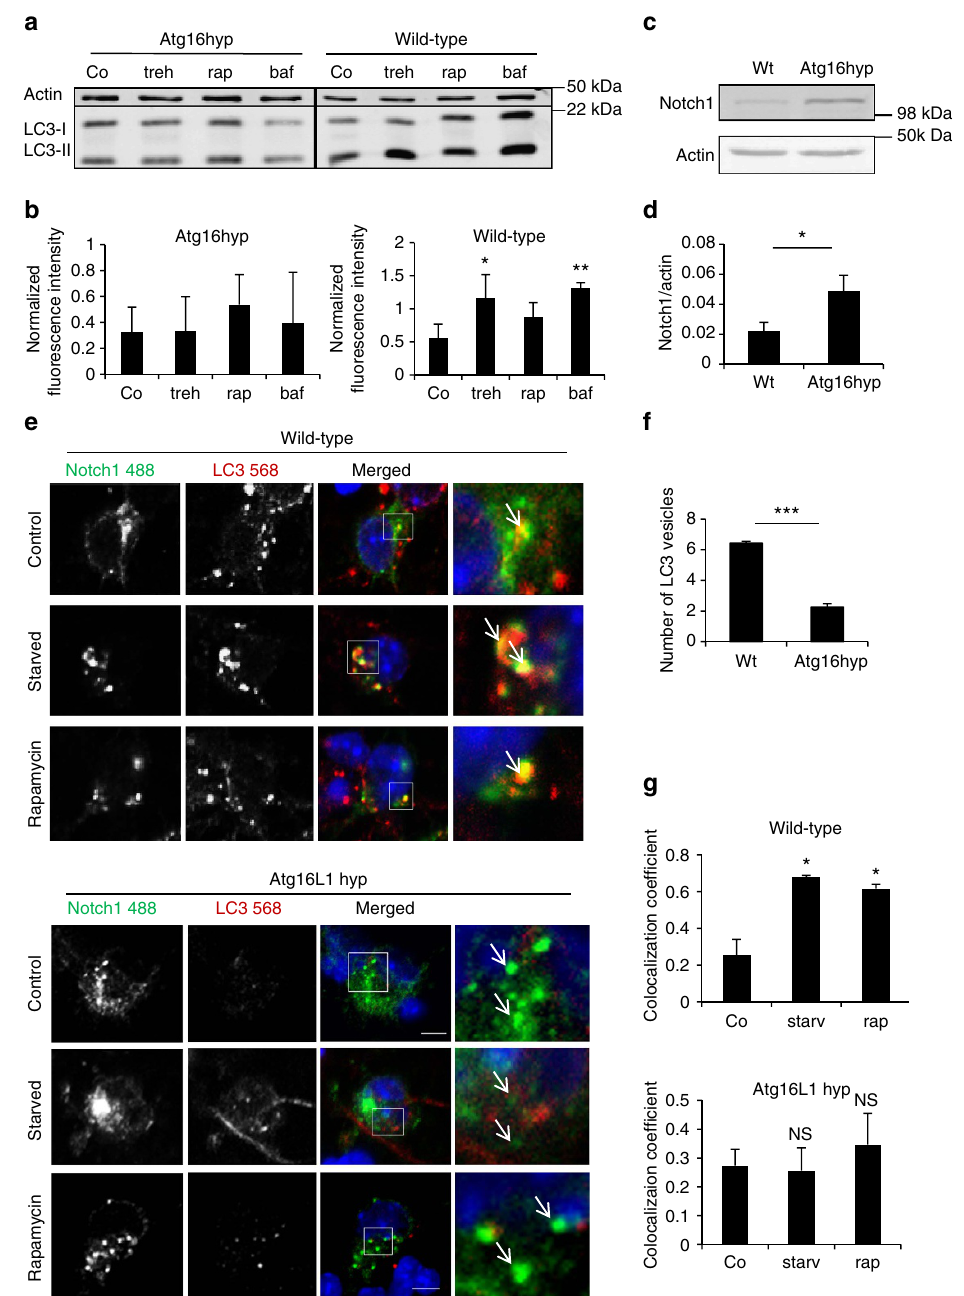
Figure 6 | Autophagy modulates Notch1 in primary neurons. ( a ) Representative western blot of LC3-II levels in wild-type and Atg16L1 hypomorph (Atg16hyp) mice. E15.5 wild-type and Atg16L1 hyp primary cortical neurons were lysed after treatment with DMSO (Co), trehalose (treh), rapamycin (rap) and bafilomycin A1 (baf) for 8h and analysed by western blot. ( b ) LC3-II protein level relative to actin loading control from western blots in a. * P o 0.05 and ** P o 0.01 by unpaired t -test. n ¼ 3. Error bars ¼ s.e.m. ( c ) Representative western blot showing Notch1 level in brain lysates from wild-type and Atg16L1 hyp 5-week-old animals. ( d ) Quantification of western blots for Notch1 in wild-type and Atg16L1 hypomorph mice (Atg16 hyp). * P o 0.05 by unpaired t -test. n ¼ 4 mice per group. Error bars ¼ s.e.m. ( e ) Effect of pharmacological autophagy modulation on the colocalization of Notch1 with LC3 in wild-type (E15.5) and Atg16L1 hyp primary cortical neurons. Neurons were treated with DMSO (Control), starved with HBSS for 2h or treated with rapamycin (8h). Arrows denote Notch1 and LC3 colocalization. Scale bar, 5 m m. ( f ) Number of LC3 vesicles in neurons from wild-type compared to Atg16L1 hypomorph (Atg16hyp) mice. Mean number of LC3 vesicles per cell is shown based on counting vesicles in at least 15 cells per condition *** P o 0.001 by unpaired t -test. n ¼ 3. Error bars ¼ s.e.m. ( g ) Mander’s colocalization coefficient of Notch1 and LC3 in wild-type and Atg16L1 hyp primary neurons. * P o 0.05 or *** P o 0.001 by unpaired t -test relative to control (Co). Error bars represent standard error of the mean. n ¼ 3. Error bars ¼ autophagy was induced by starvation (Fig. 5c). The adaptor ATG16L1/AP2 double-positive structures (Supplementary required for the internalization of ATG16L1 via clathrin-coated Fig. 6c), consistent with the idea that Notch1 can be inter- pits is AP2 (ref. 23). We were able to observe Notch1 localizing in nalized and trafficked to autophagosomes alongside ATG16L1.